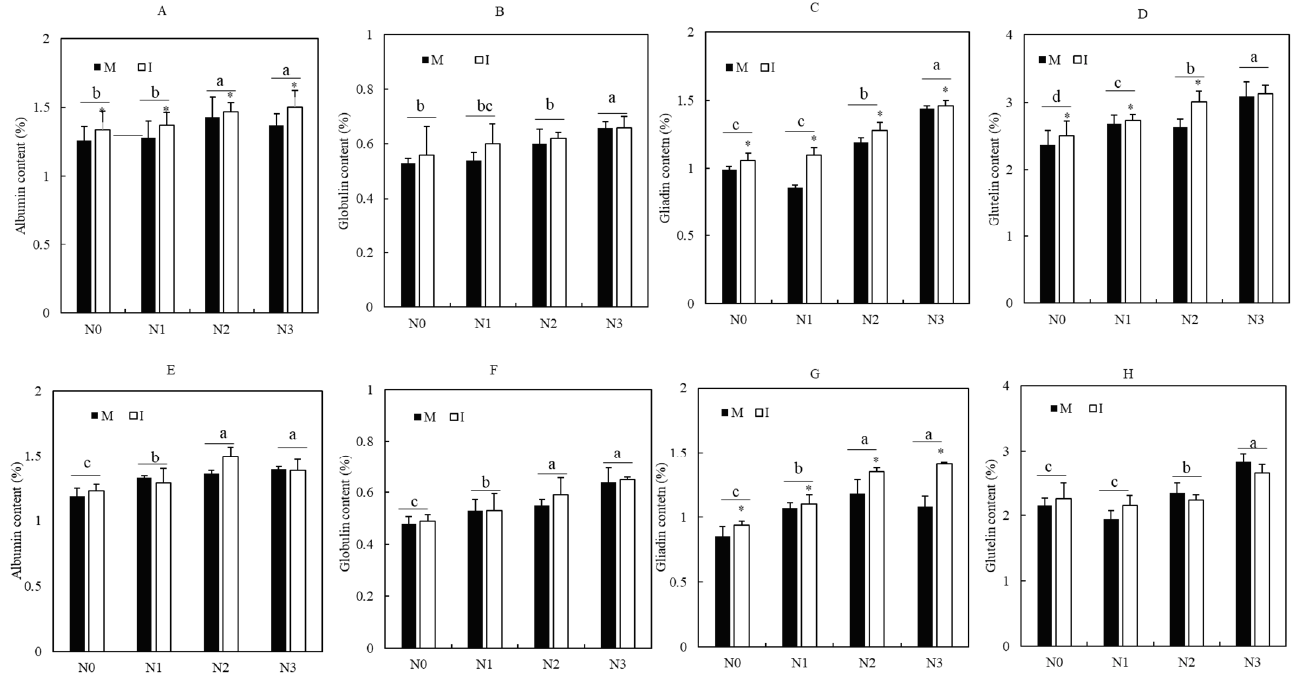
Figure 3. Grain protein fraction content between IW and MW under different N levels. MW, mono − cropped wheat; IW, intercropping wheat. ( A – D ) Albumin, globulin, gliadin, and glutelin content of IW and MW in 2019, respectively; ( E – H ) albumin, globulin, gliadin, and glutelin content of IW and MW in 2020, respectively. Different letters represent significant differences among differ- ent N levels ( p < 0.05); * represents significant differences between IW and MW ( p < 0.05). Each bar in the figures is the mean value (n = 3), and error bars represent the standard error. Table 2. Two − way ANOVA analysis of grain protein composition for inter − and mono − cropped wheat under different N